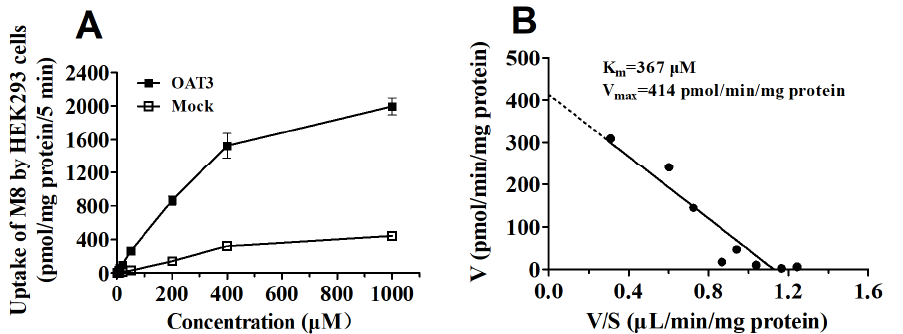
Figure 10. Concentration-dependent profile ( A ) and Eadie–Hofstee plot ( B ) for the uptake of M8 in mock and hOAT3-HEK293 cells. Uptakes of M8 in mock and hOAT3-HEK293 cells were measured at concentrations between 2 and 1000 µM. Data are expressed as mean ± SD, n = 3.